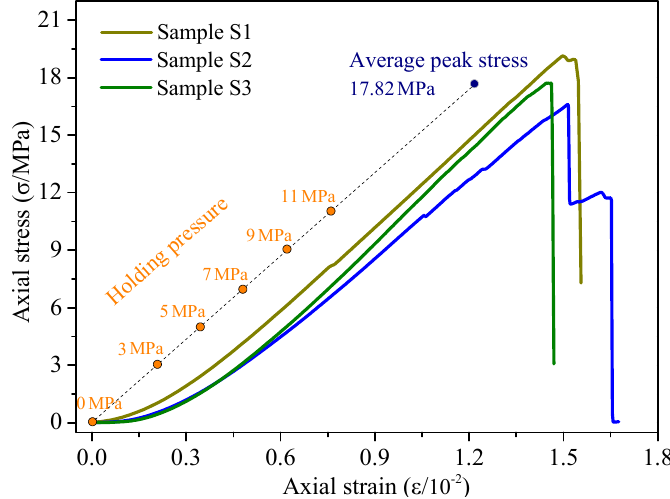
Figure 6. Stress–strain curve of the Group S coal sample.